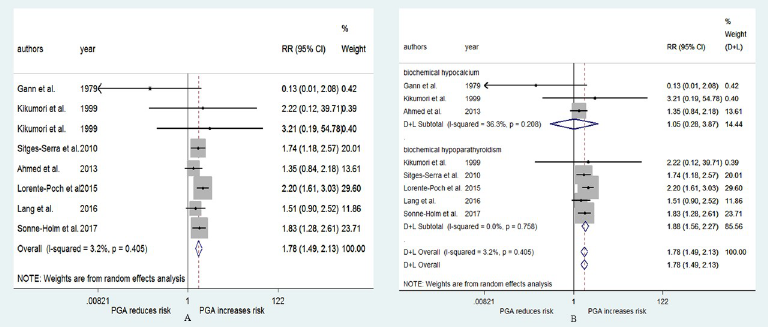
Fig 3. RR for protracted hypoparathyroidism in patients who underwent PGA vs patients who not underwent PGA. (A) overall relative risks. (B) the relative risk in subgroup of different evaluation indexes.